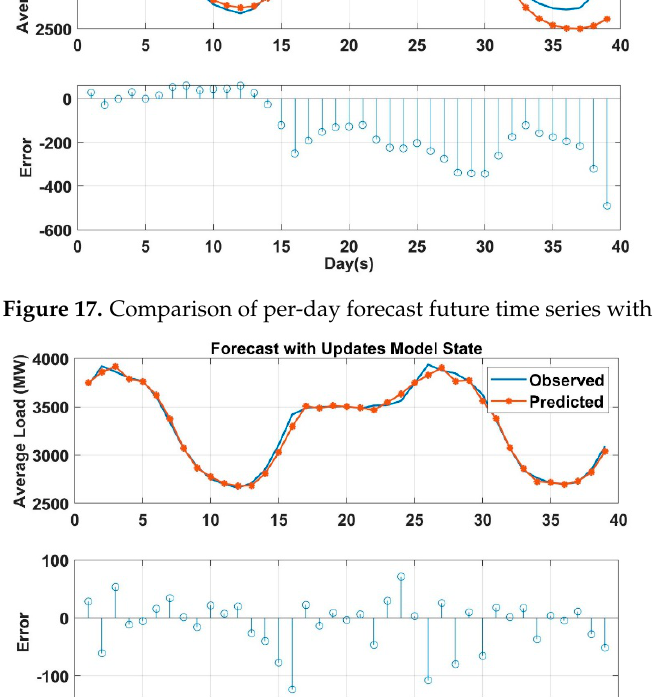
Figure 18. Comparison of per-day forecast future time series using updated DNN model with test